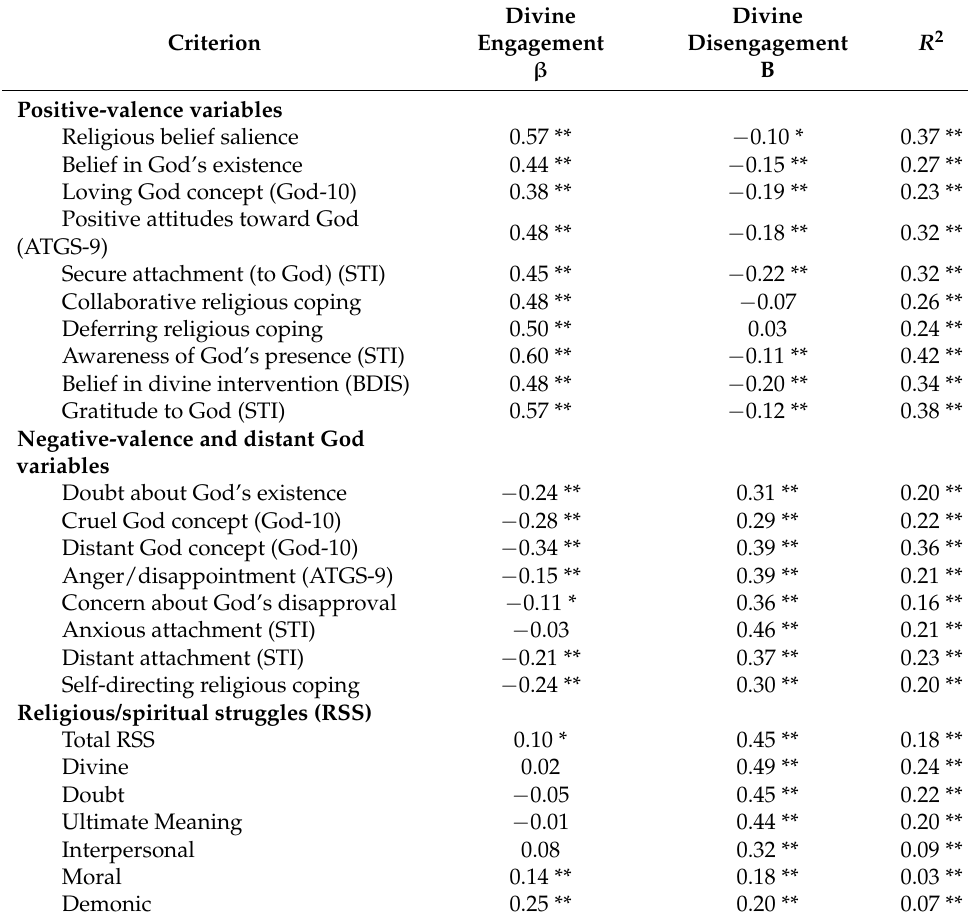
Table 7. Simultaneous Regressions Predicting Key Variables from Divine Engagement and Disen-